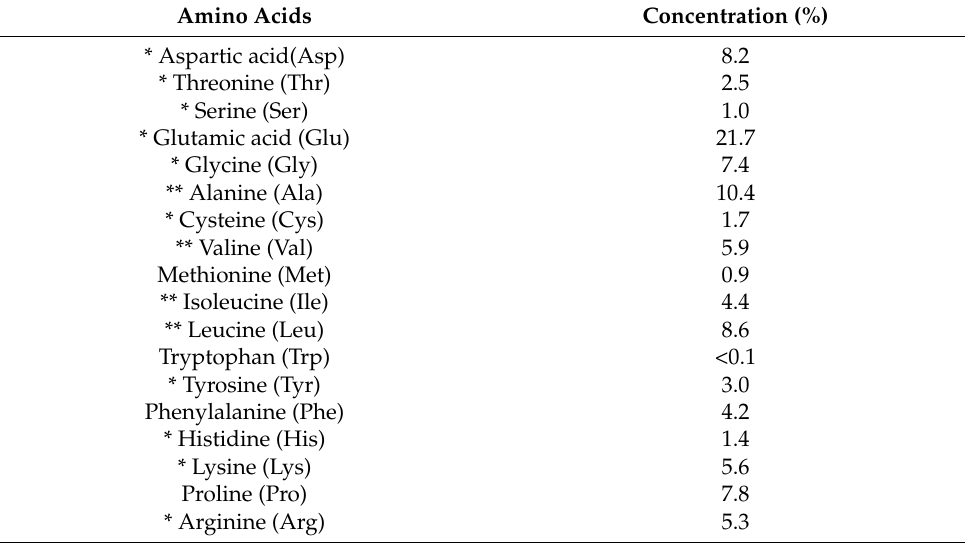
Table 2. Amino acid composition of the soy protein isolate. * Hydrophilic groups. ** Hydropho- bic